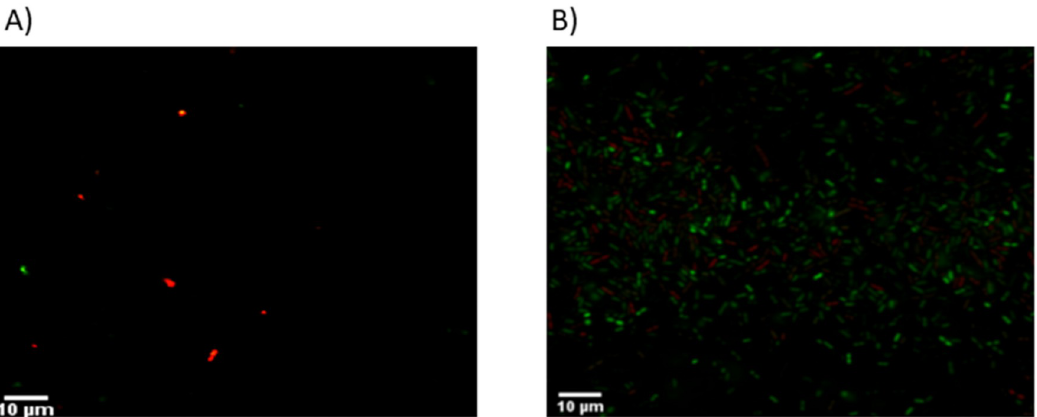
Fig 5. Confocal images of SYBR 1 gold and PI staining following (A) bacteriophage treated and (B) untreated K . michiganensis biofilm. Green color indicates live cells, red/orange color indicates dead cells on the slides.